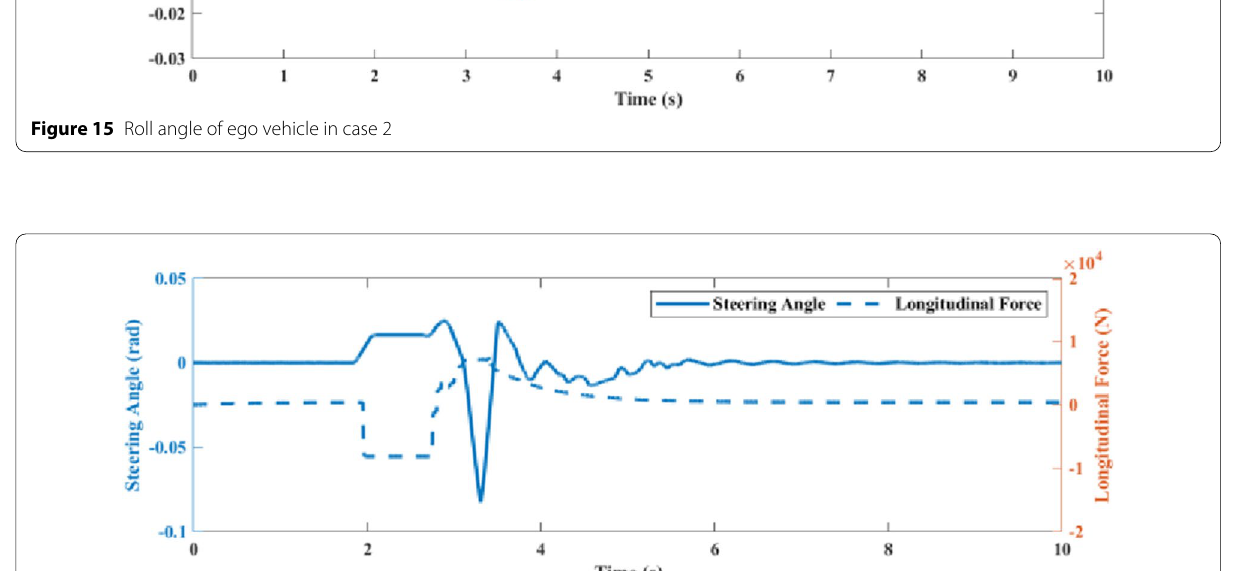
Figure 16 Steering angle and longitudinal force of ego vehicle with UAMP-RR method in case